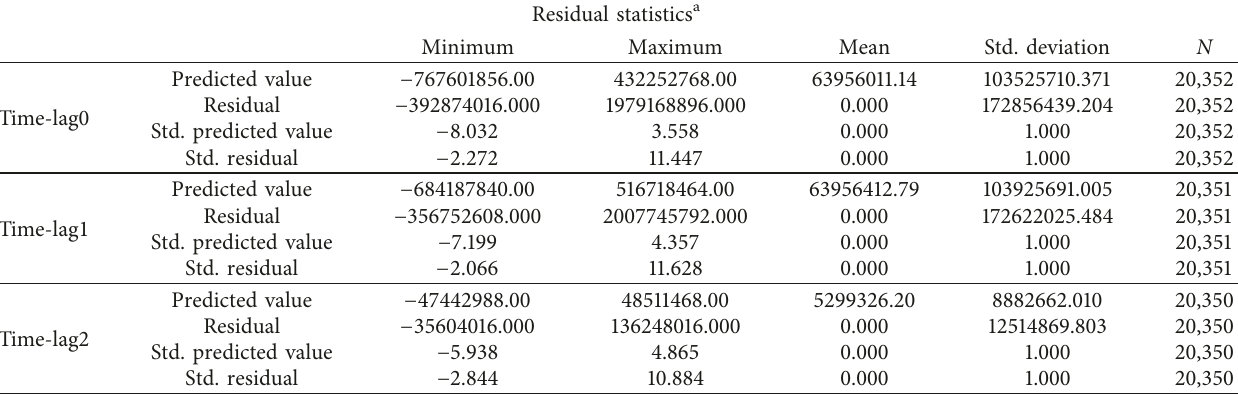
Table 21: Residual statistics for a DOE large office building depending on time-lag.